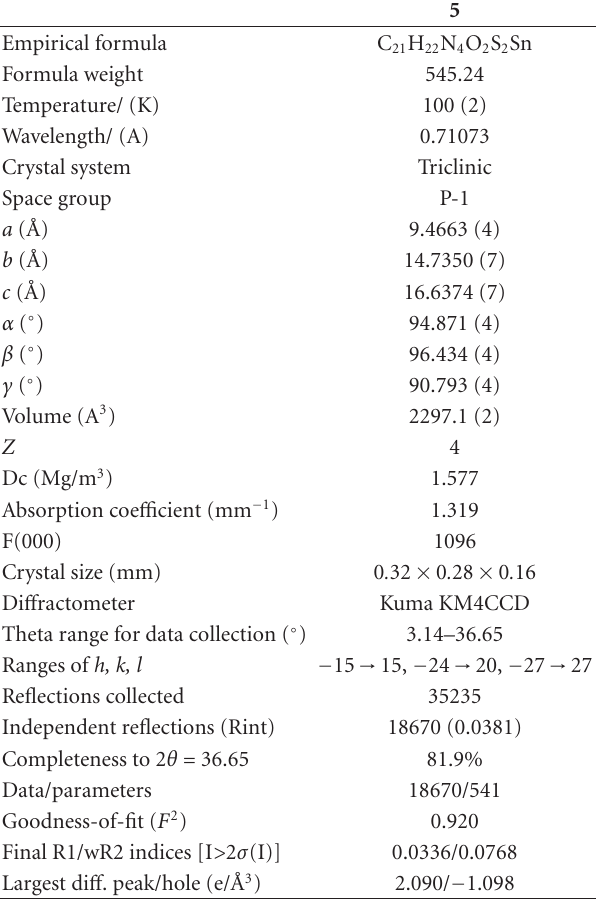
Table 1: X-ray crystal data and structure